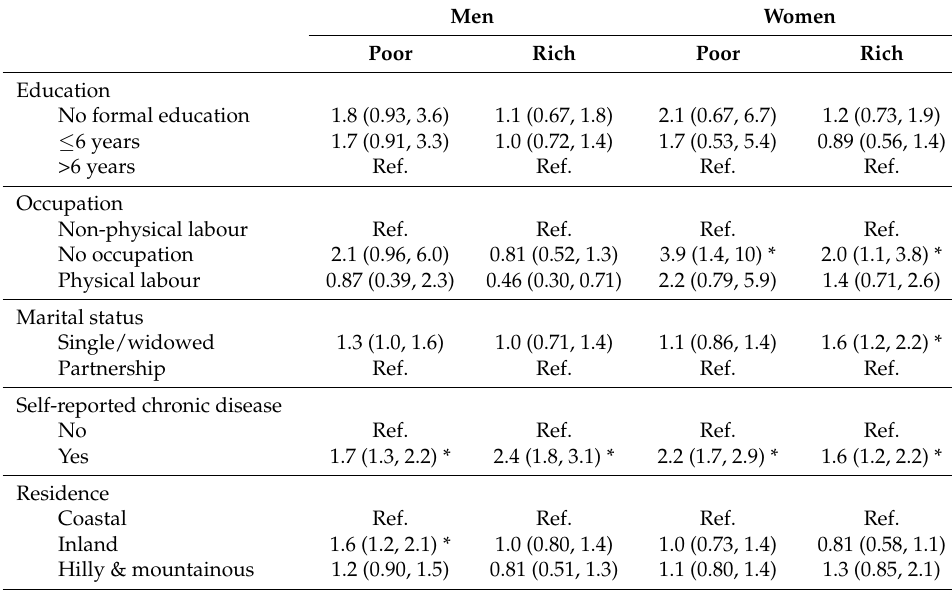
Figure 2. Nelson-Aalen cumulative hazard curve in men and women, stratified by wealth and abdominal obesity status during the study period (2007–2010). WHO-INDEPTH SAGE Purworejo longitudinal data.